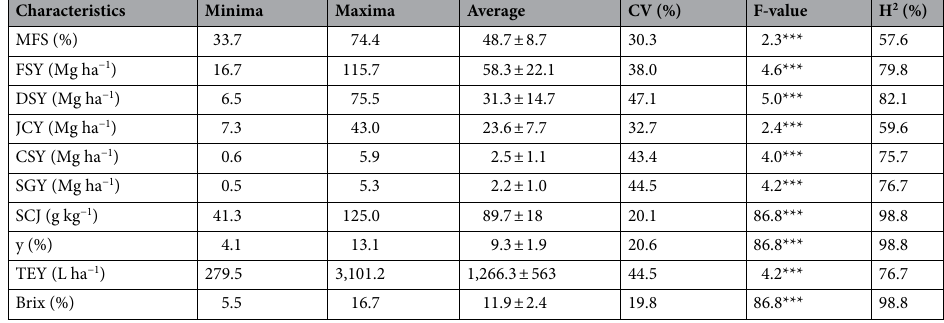
Table 4. Analysis of variance of twelve characteristics determining sugar and ethanol production in 105 accessions of semi-arid Chadian sweet sorghum. ***Indicates significance at p < 0.001 , CV; Coefficient of variation, MFS; moisture content of fresh stalk, FSY; fresh stalk yield, DSY; field dried stalk yield, CSY; conservative sugar yield, JCY; juice yield, SGY; sugar yield, SCJ; sugar concentration of juice, TEY; Theoretical ethanol yield, y; total soluble sugar. ± standard error.